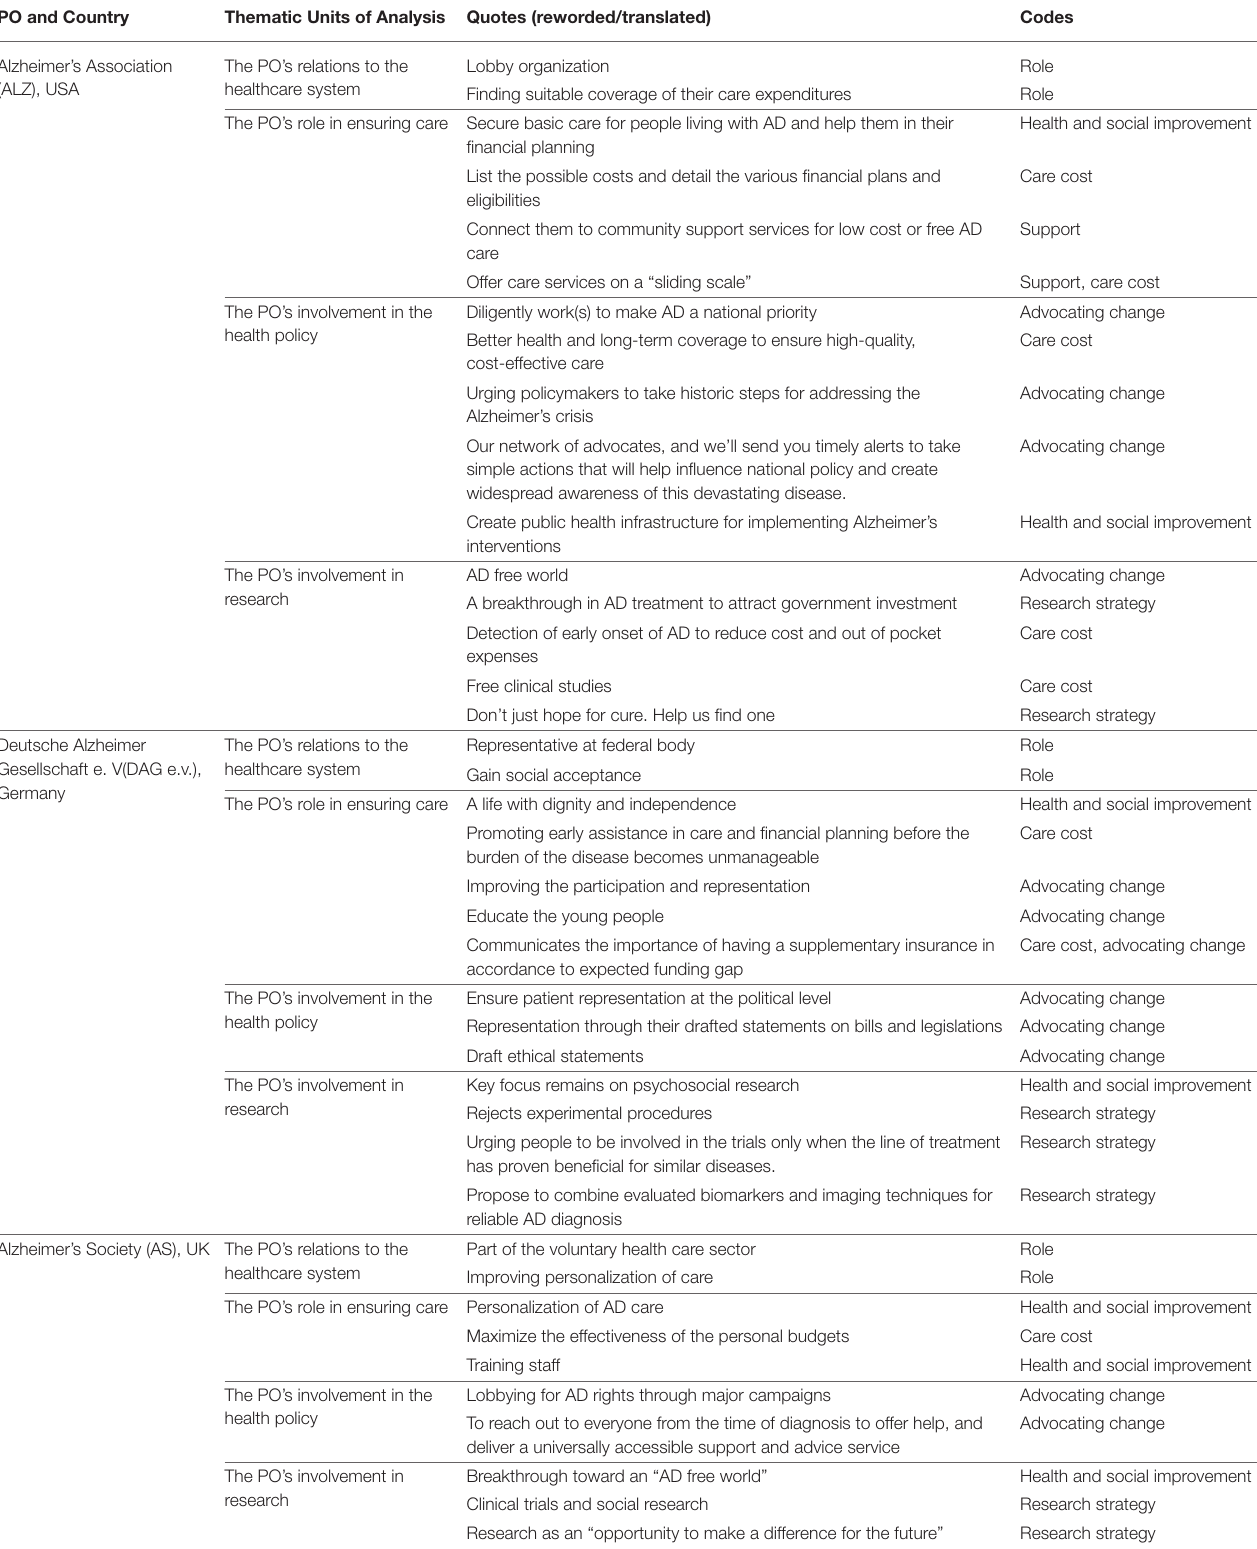
TABLE 1 | Inductive content analysis of the AD PO websites. PO and Country Thematic Units of Analysis Quotes